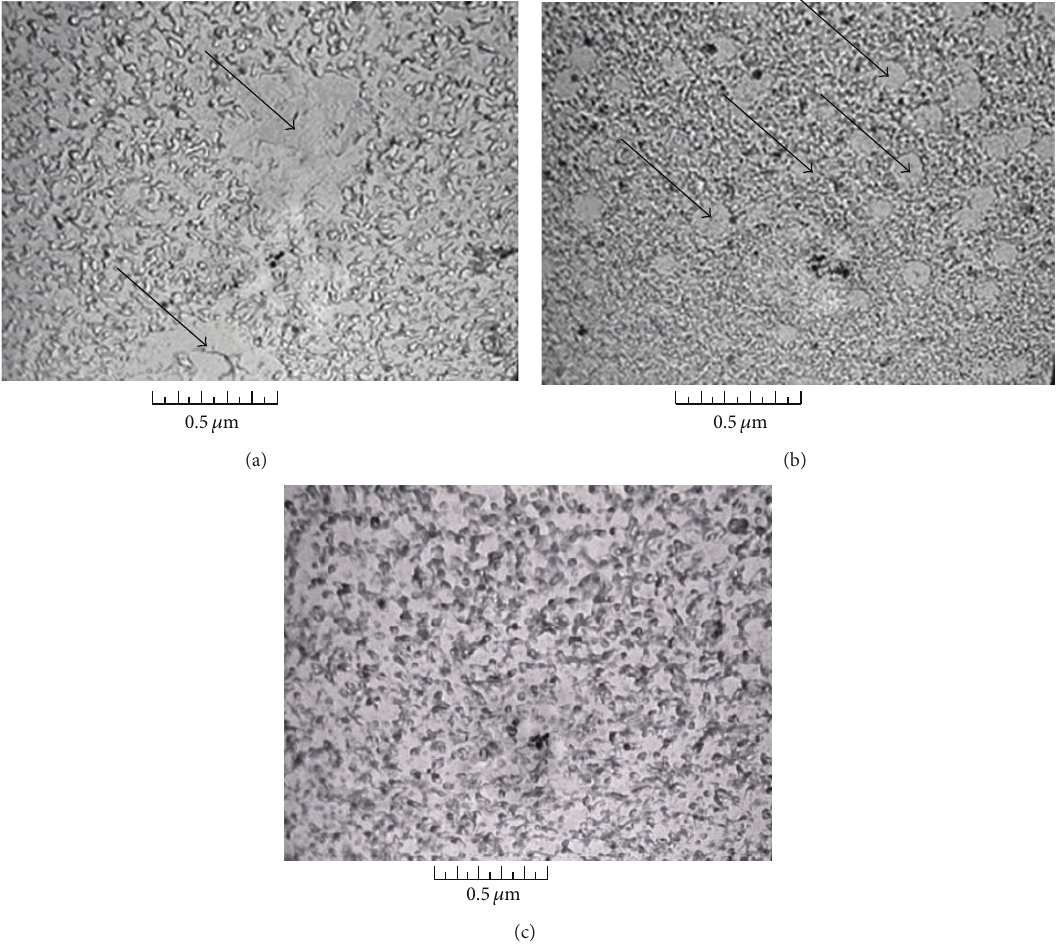
Figure 3: TEM data for the Fe25 (a), Fe20 (b), and Fe15 (c) glasses. Arrows indicate the agglomerates formed the drop structure